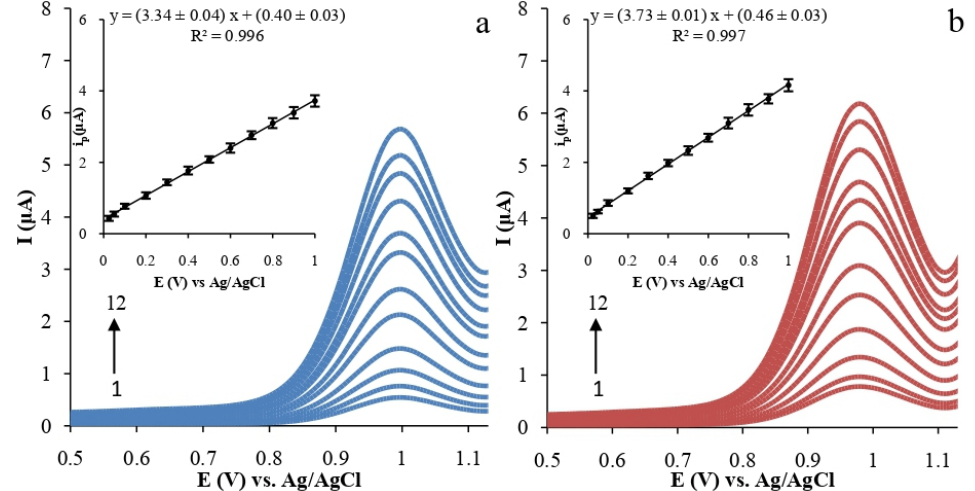
Figure 6. DPV of ( a ) R-Nap and ( b ) S-Nap solutions of various concentrations on GCE/PEC–[Zn( S -Ala) 2 (H 2 O)]–[Zn( S -Phe) 2 (H 2 O)]: 0.025 (1), 0.05 (2), 0.1 (3), 0.2 (4), 0.3 (5), 0.4 (6), 0.5 (7), 0.6 (8), 0.7 (9), 0.8 (10), 0.9 (11), 1 (12) mM (phosphate buffer solution with pH 6.86, potential scanning rate 0.2 V/s). Insets: the corresponding calibration